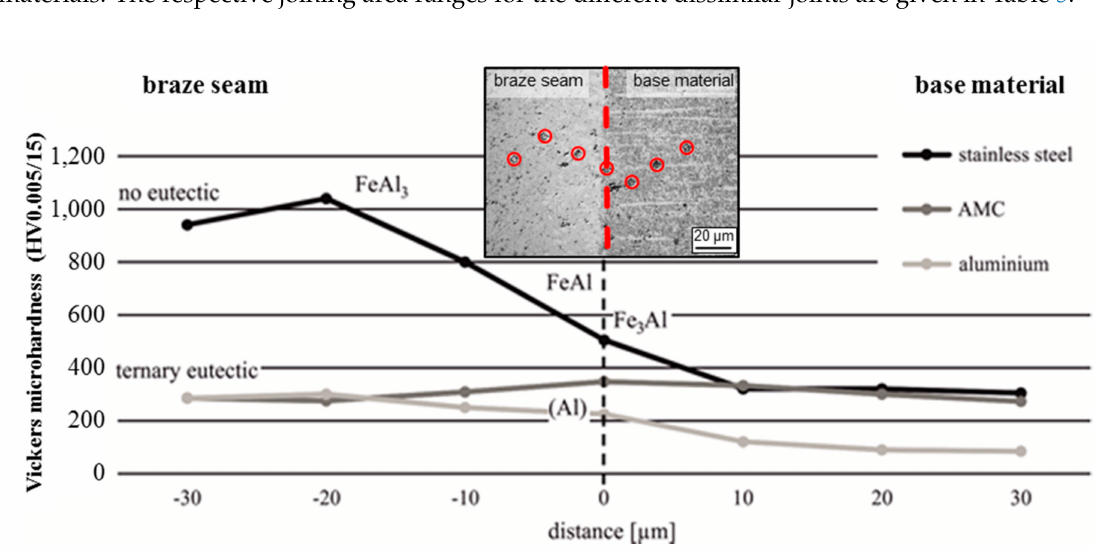
Figure 6. Hardness profiles at the investigated interfaces in dissimilar joints